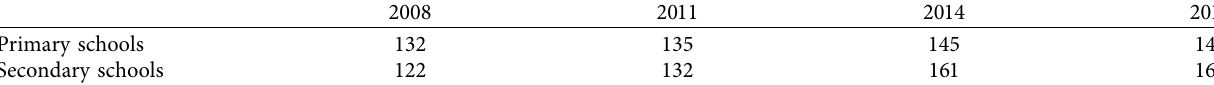
Table 5: The coefficients of variation of RCMW in primary and secondary schools in Liaoning Province.